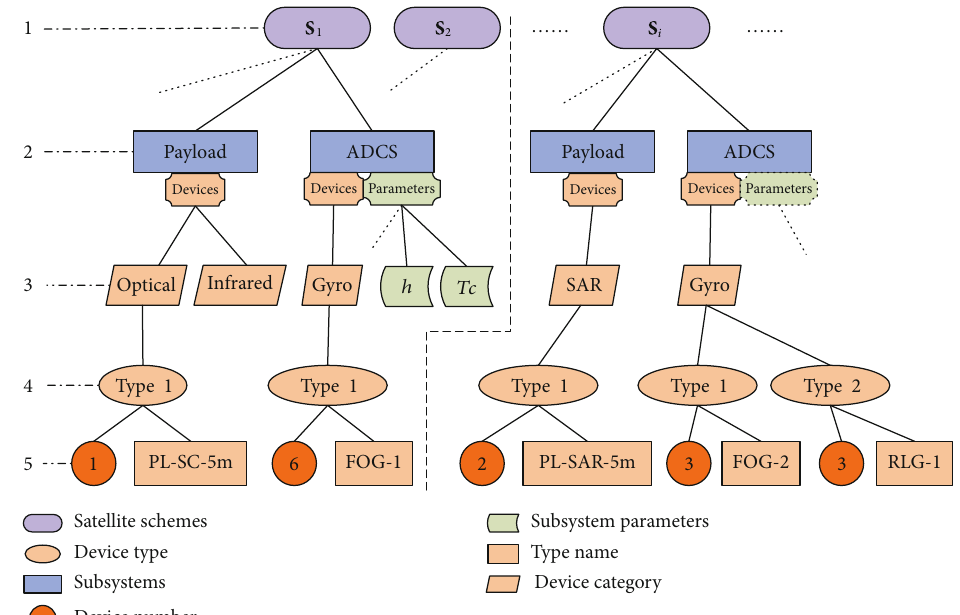
Figure 2: Tree structure topology of satellite system composition